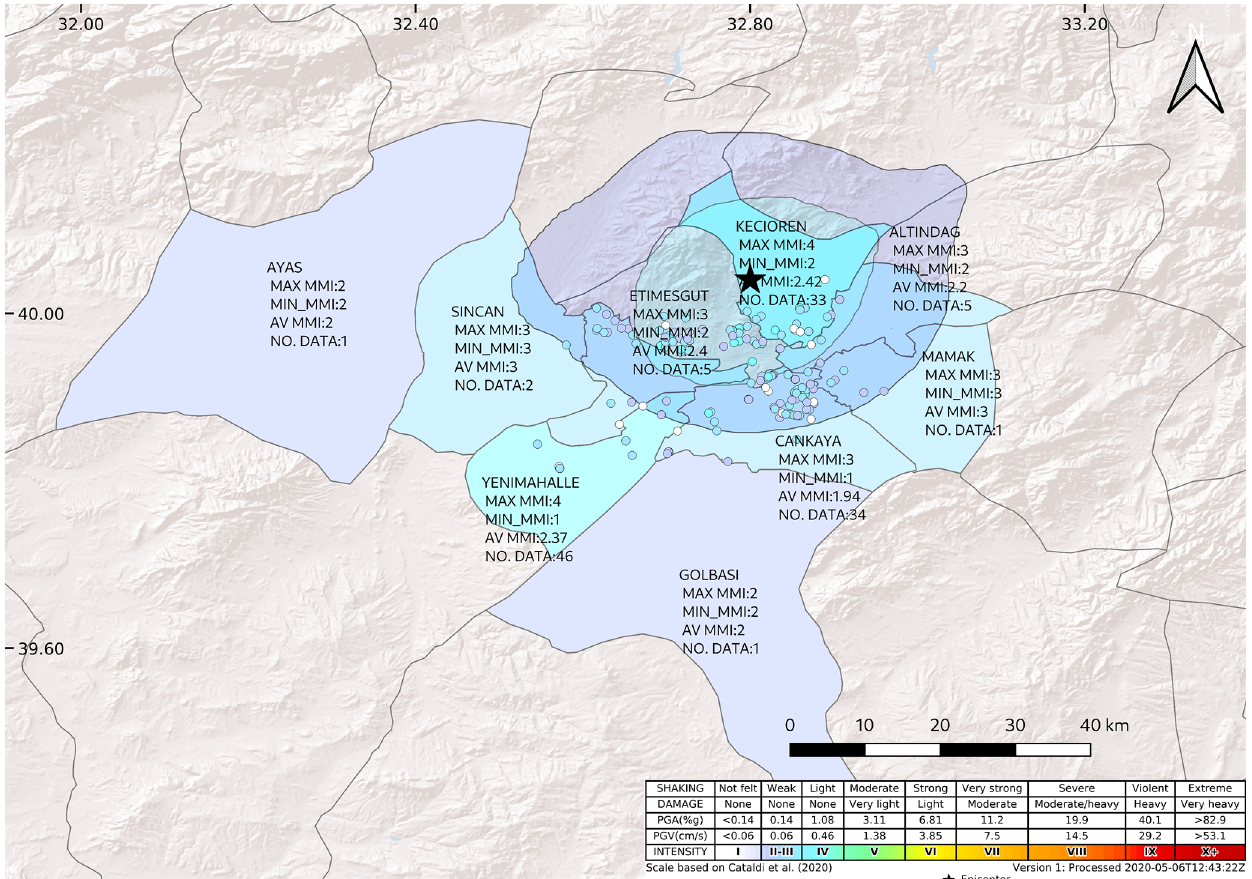
Figure 3. Intensity map of the 25 August 2019 Ankara earthquake with labeled entries. Entries are plotted to district level polygons. Felt reports of the earthquake submitted to EMSC are at the top of the labeled entries (created using